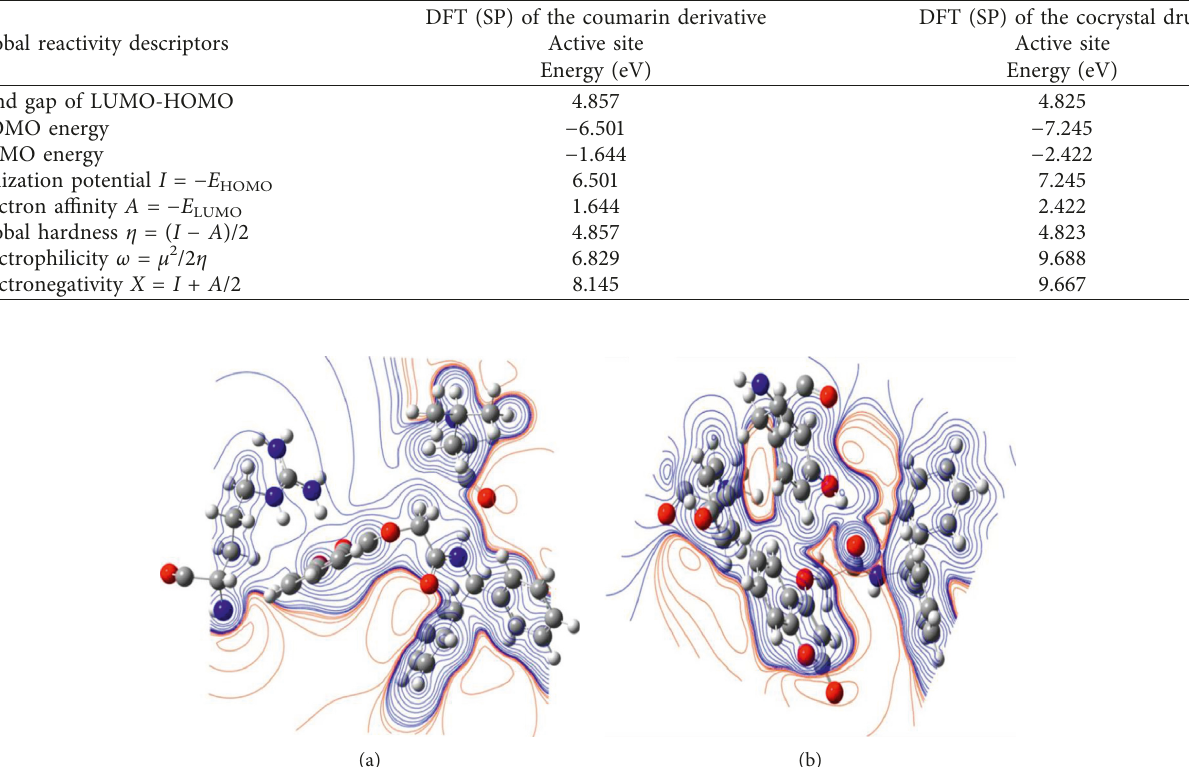
Table 5: The calculated global reactivity properties of the coumarin derivative